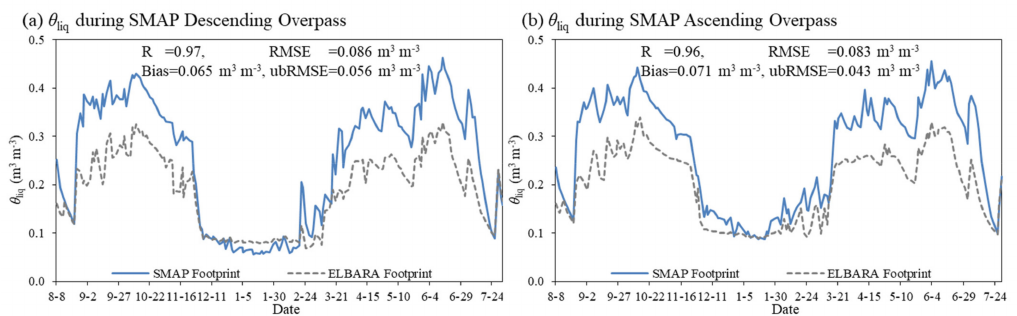
Figure 4. Time series of averaged θ liq at a depth of 5 cm taken from in situ data collected within ELBRA-III and SMAP footprints during the ( a ) descending and ( b ) ascending overpasses of SMAP mission between August 2016 and July